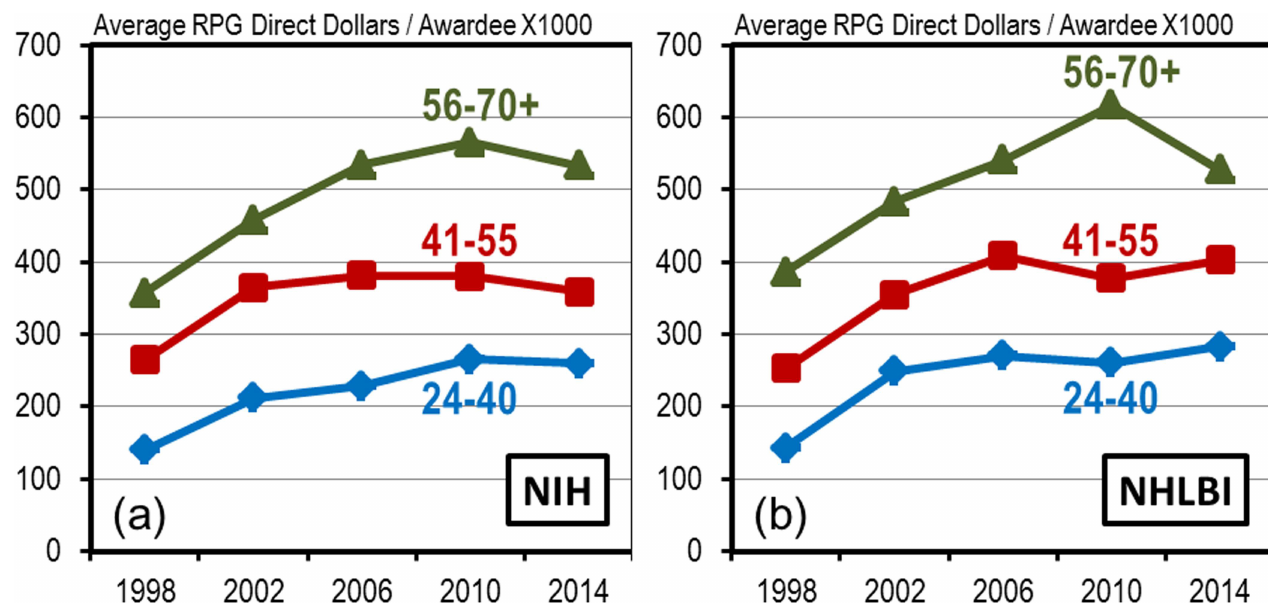
Fig 8. Disproportionate Allocation of Total RPG Direct Dollars. A verageamount of total RPG direct dollars per awardeeby age group for selectedyears between 1998and 2014 at (a) NIH and (b)